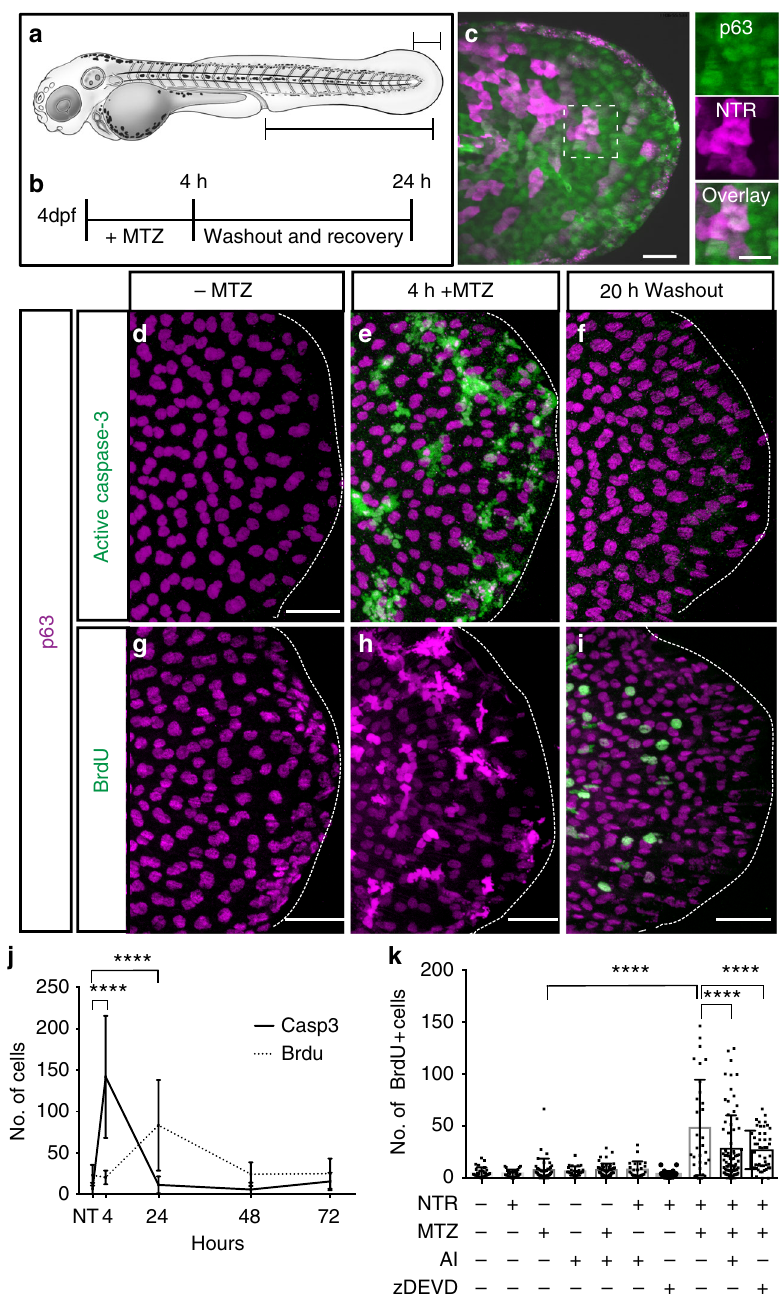
Fig. 1 Caspase-dependent proliferation after stem cell ablation. a Schematic of a 4-day post-fertilization (dpf) zebra fi sh larvae. Large region denotes area of the animal where cell death and proliferation were quanti fi ed before and after cell ablation. Small region marks the area used for fi xed and live imaging. b Timeline for the addition and removal of metronidazole (MTZ). c The zc1036a GAL4 enhancer trap line drives expression of fl uorescently tagged nitroreductase (NTR) in a subset of p63-positive basal stem cells (scale = 100 µ m, 50 µ m inset). Maximum intensity projections of confocal images for activated caspase-3 ( d – f ) and bromodeoxyuridine (BrdU) ( g – i ) at different points after inducing damage (scale = 50 µ m). j Quanti fi cation of active caspase-3- and BrdU-positive cells reveals a temporal relationship for the proliferative response. Mean number of positive cells from at least n = 11 individual larvae across three independent experiments per time point are plotted. NT = No treatment. k Mean number of BrdU-positive cells in individual larvae after induced apoptosis ( n = 31) and in combination with treatment of the apoptosis inhibitor, NS3694 (AI) ( n = 77) or caspase-3 peptide inhibitor zDEVD-fmk (zDEVD) ( n = 49). Data are from three independent experiments and error bars represent sd; **** p < 0.0001. One-way analysis of variance (ANOVA) with Dunnett ’ s mutiple comparisons test ( j , k